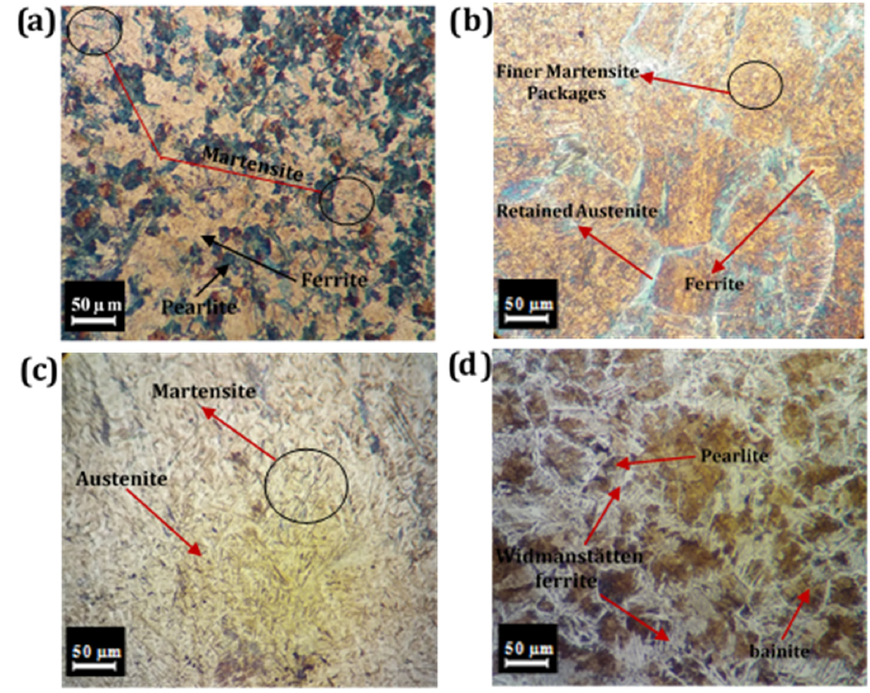
Figure 5. Microstructures of TIG welded samples using different filler metals: ( a ) without filler metal, ( b ) ER70S-6 filler metal, ( c ) ER80S-B2 filler metal and ( d ) R60 filler metal. ( b ) ER70S-6 filler metal, ( c ) ER80S-B2 filler metal and ( d ) R60 filler